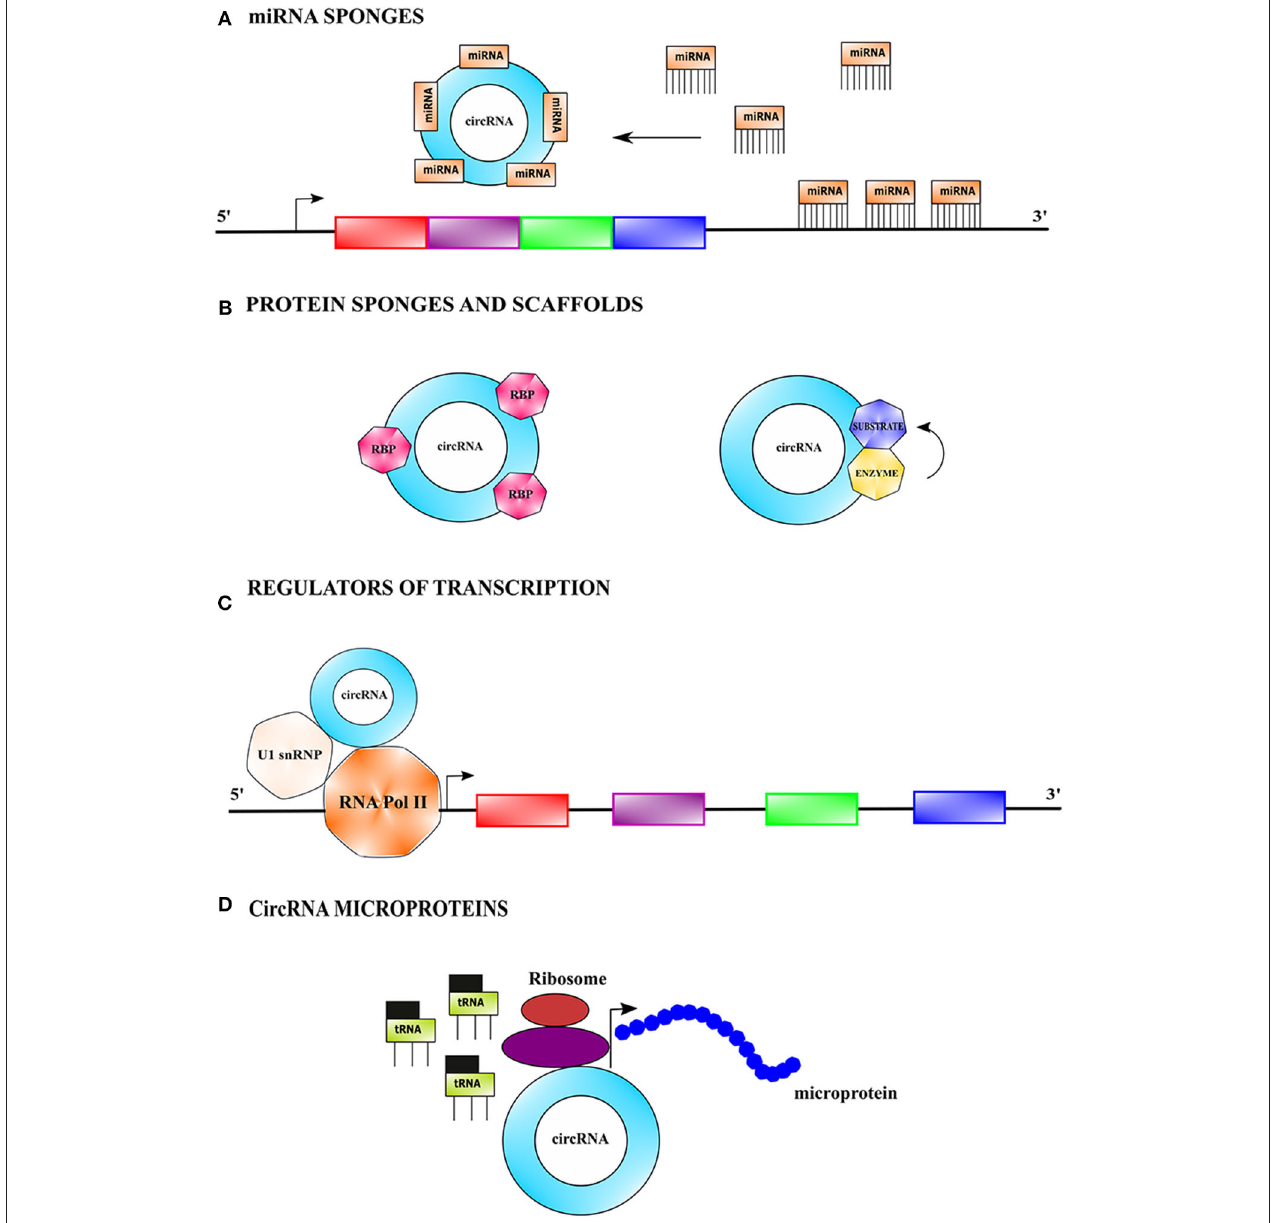
FIGURE 2 | Mechanistic action of circular RNAs. (A) CircRNAs can serve as miRNA sponges by competitively binding to miRNA(s) via base-pairing interactions, causing stabilization of target transcript(s) of the sequestered miRNA(s), and thus making it more available for translation. (B) CircRNAs can sponges protein by binding to them and thus indirectly regulating their functions. CircRNAs can also function as protein scaffolds by facilitating colocalization of an enzyme and its substrate to influence the kinetics of catalysis. (C) CircRNAs can modulate transcription by binding to RNA polymerase II complex bearing the U1 small nuclear ribonucleoprotein among other proteins and augment the function of certain proteins of the complex. (D) CircRNAs bearing internal ribosome entry site (IRES) elements and initiation codons can initiate translation in a cap-independent fashion and generate short polypeptides referred to as microproteins.